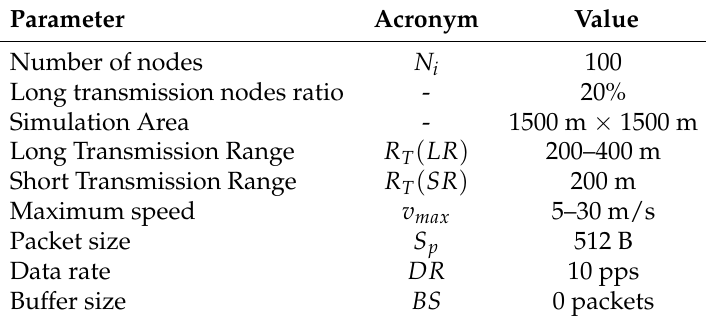
Table 3. Summary of our simulation